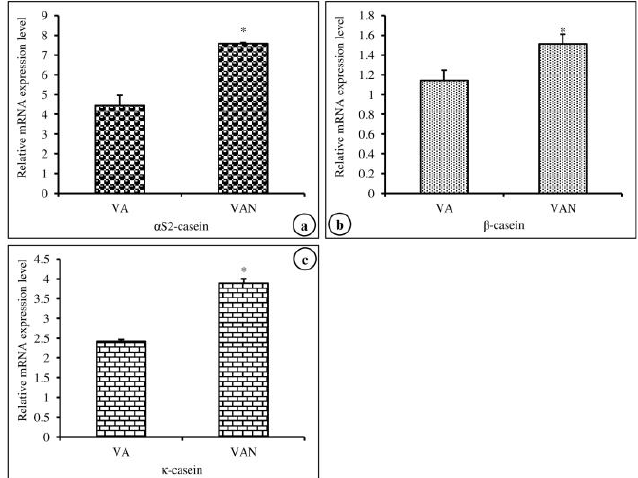
Figure 5. E ff ect of nanoemulsion-free vit-A (VA) and nanoemulsified vit-A (VAN) on casein gene expression in MAC-T cells as evaluated by quantitative RT-PCR. The nanoemulsified vit-A had stimulatory e ff ects on the α s2 - ( a ), β - ( b ), and κ -casein ( c ) expression when compared with the non- nanoemulsified vitamins, as the average ( ± SEM of the average) of three independent experiments.